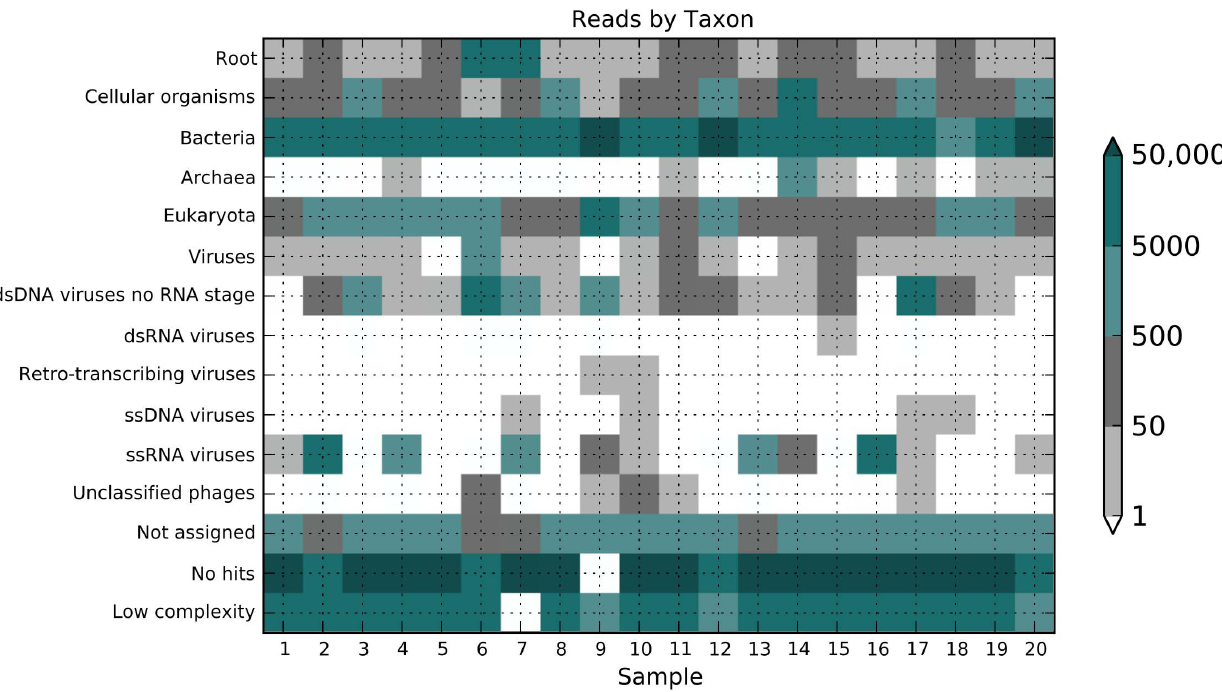
Figure 4. Taxonomy of reads in each sample. 100,000 random reads from each sample dataset were subject to a nucleotide BLASTN search and hits with e values less than 0.001 were collected, and processed with MEGAN4 (see Materials and Methods). The Megan output was processed using Python script to generate a heat map of total reads in each sample in each category. Values were grouped into 5 categories and depicted with the following colors: less than 0 reads, white; 1–50 reads, grey; 51–500 reads, dark grey; 501 to 5000 reads, light green; 5001 to 50,000 reads, green, . 50,000 reads, dark green (also see color bar scale to right of figure).